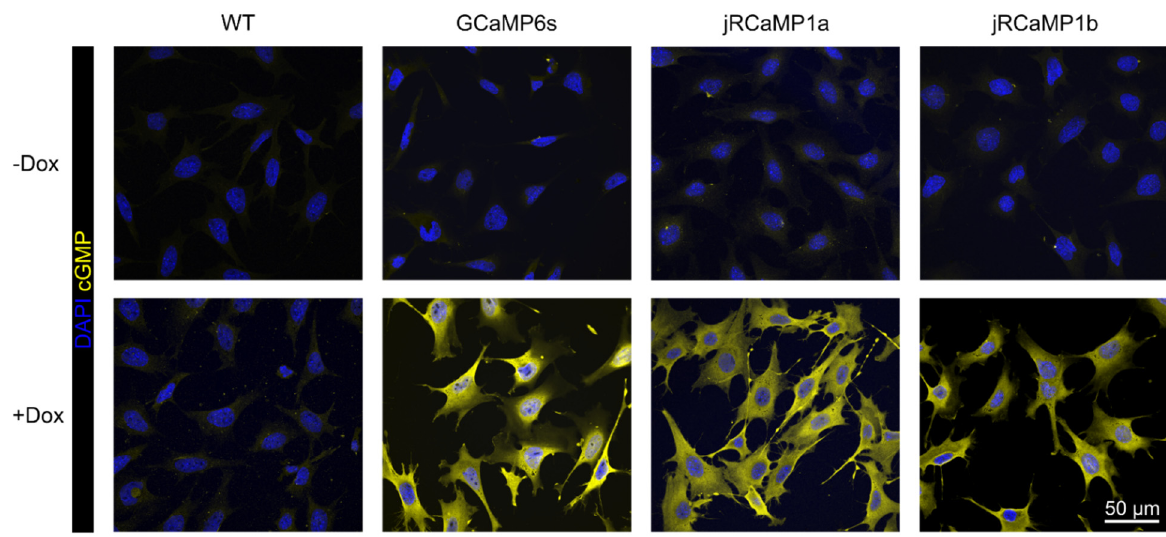
Figure 2. Validation of light-inducible production of cGMP by RhGC in the three engineered HeLa cell lines compared to the parental wild-type (WT) HeLa cells. Confocal images of cells cultured with or without doxycycline, illuminated at the RhGC activation wavelength and then immunolabeled for cGMP (yellow). Nuclei were stained with DAPI